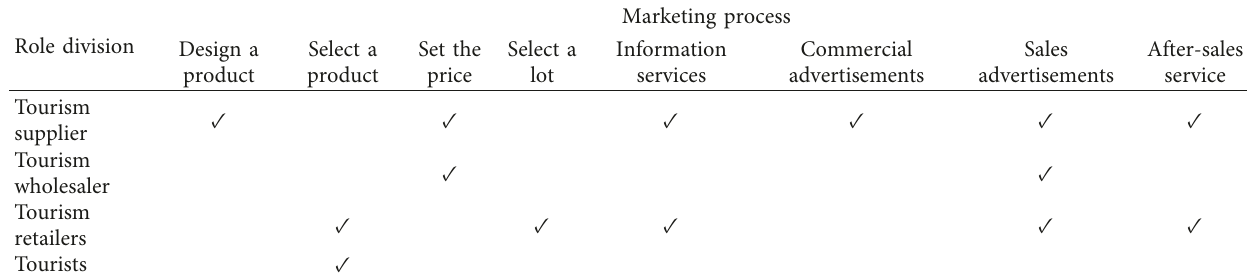
Table 1: Traditional marketing process of tourism enterprises.